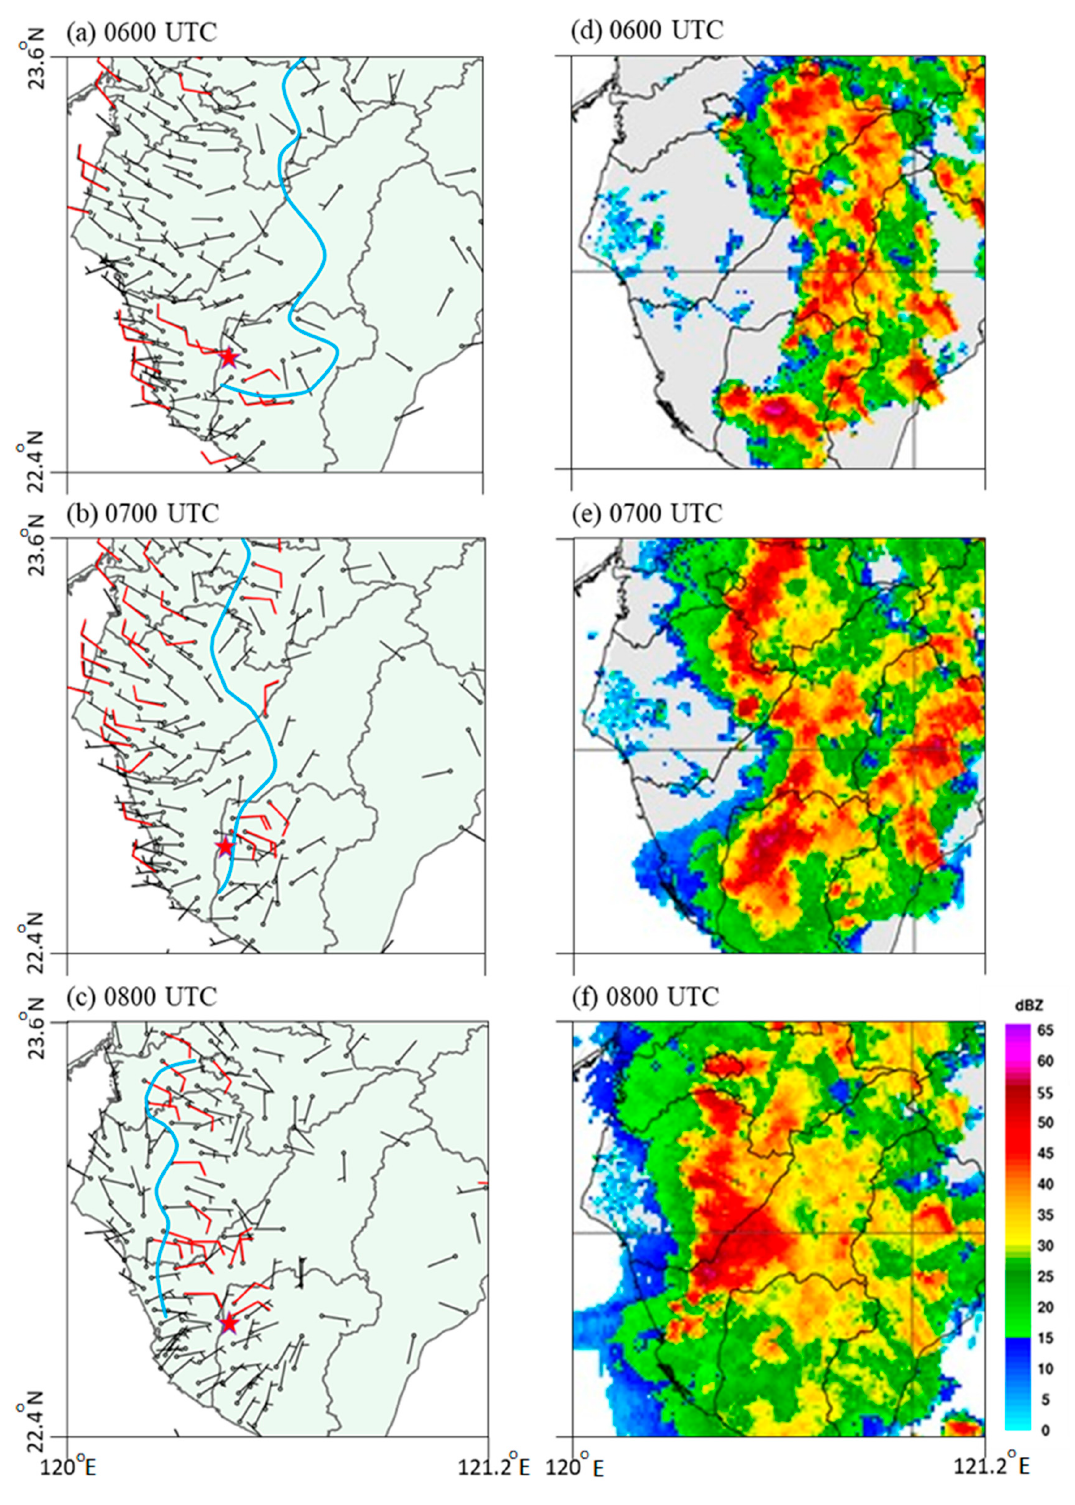
Figure 4. Surface wind observations (kt; vector) at ( a ) 0600, ( b ) 0700, and ( c ) 0800 UTC and composite radar reflectivity (dBZ; shaded) at ( d ) 0600, ( e ) 0700, and ( f ) 0800 UTC on 5 August 2018 from 134 AWSs. The location of Pingtung Airport (Pingtung meteorological station) was depicted as red star in ( a – c ) and white star in ( d – f ), respectively. The blue lines in ( a – c ) indicated the convergence line of ATs. Wind speeds more (less) than 8 kt were colored in red (black).